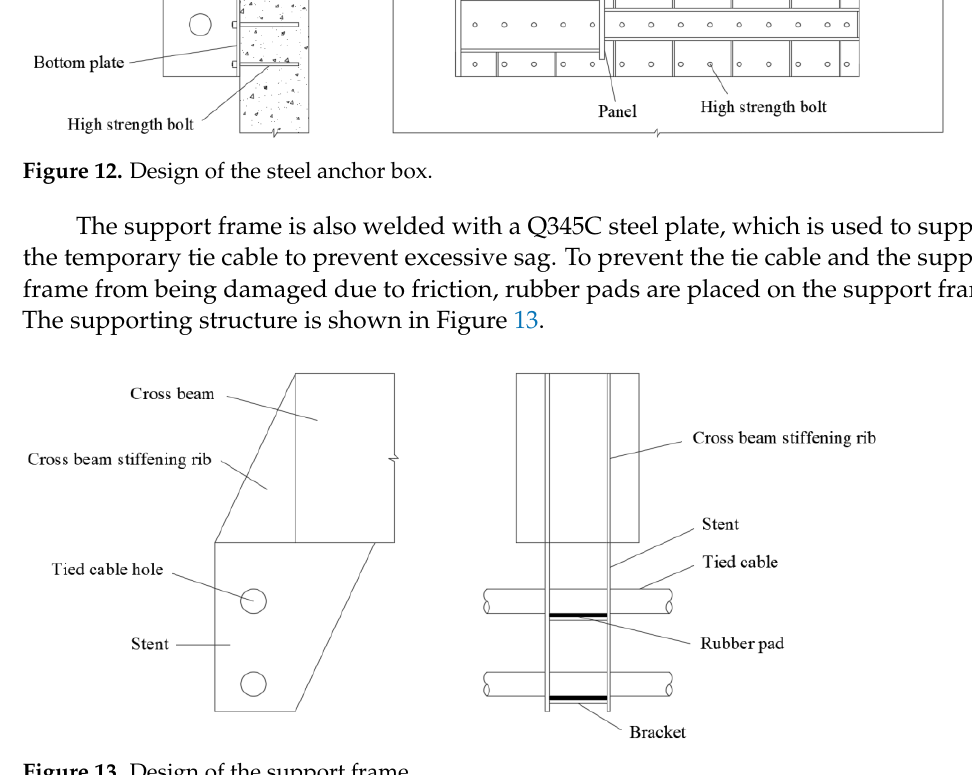
Figure 11. Temporary substitution system of the third Lingjiang bridge.